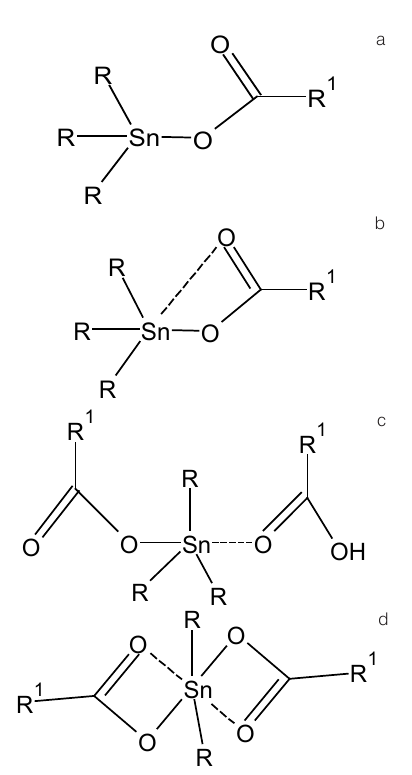
Figure 3. Proposed geometries of tri- and diorganotin(IV)